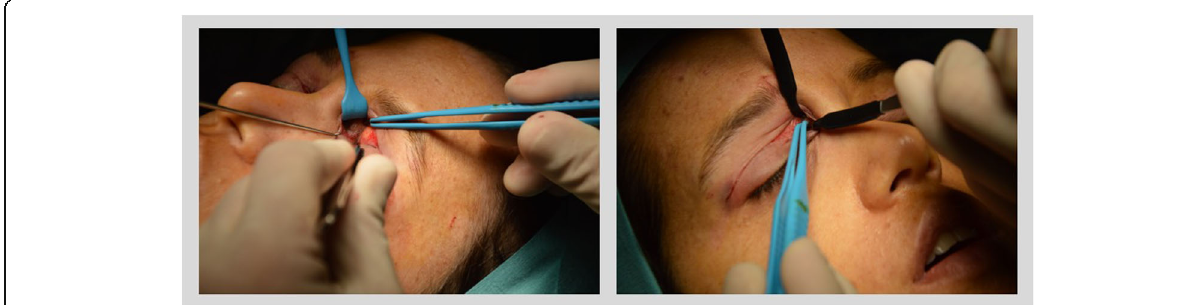
Fig. 4 Medial CSM motor innervation resection. Medial to the medial insertion of the CSM and the supratrochlear pedicle, dissection was carried out to identify the medial motor inervation of the CSM. Medial motor branches to the CSM were dissected and cauterized via bipolar coagulation